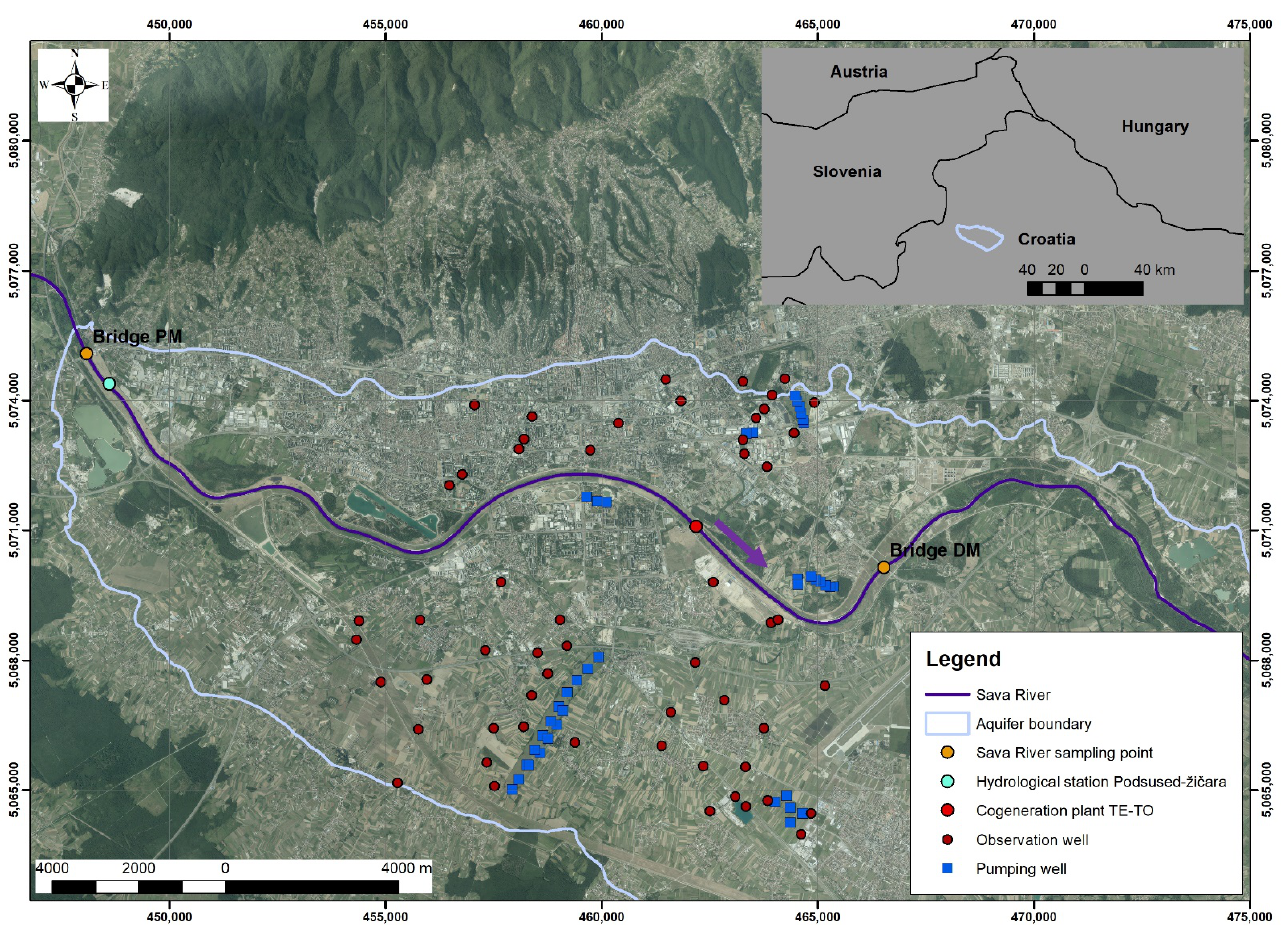
Figure 1. Research